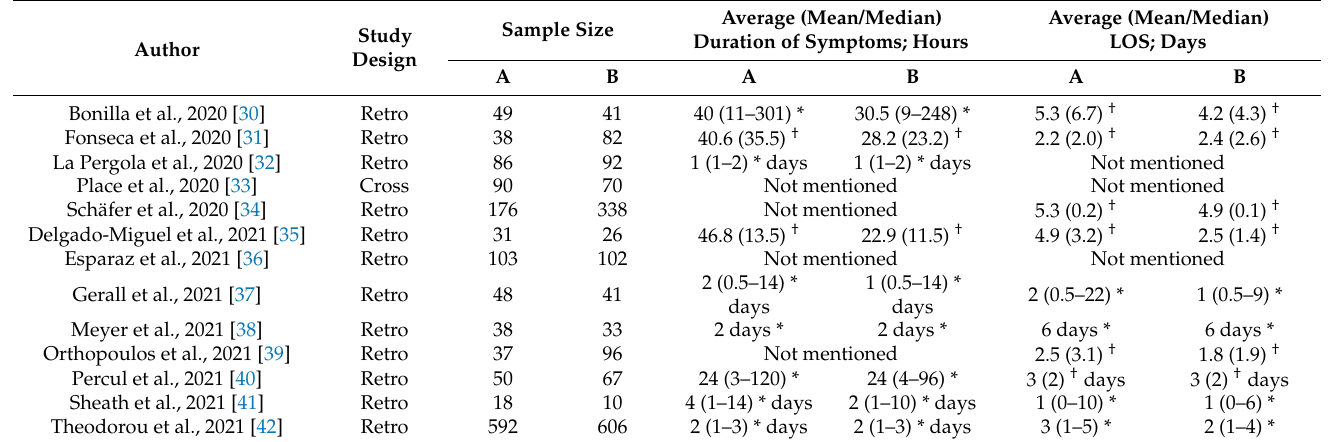
Table 1. Baseline characteristics of the studies included in meta-analysis.